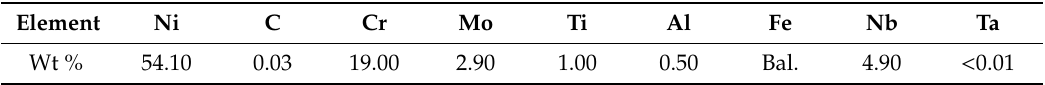
Table 1. Nominal chemical composition of Alloy 718 powder used during electron beam melting (EBM).